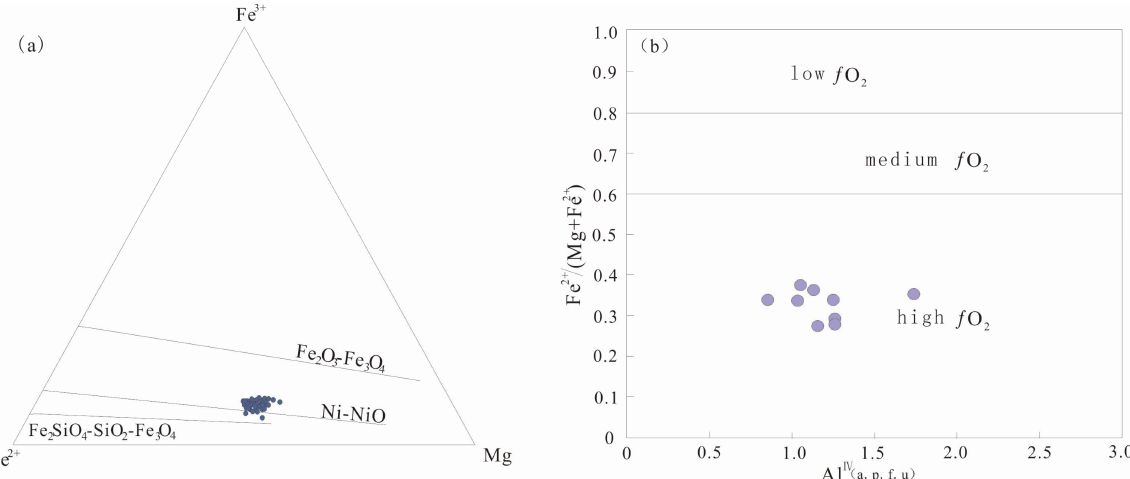
Figure 11. Plot of Fe 3+ -Fe 2+ -Mg for biotite ( a ) and Fe 2+ /(Mg + Fe 2+ ) for amphibole ( b ) from the Zhouguan granodiorite (after Wones and Eugster, 1965 [36]; Dada, 2013